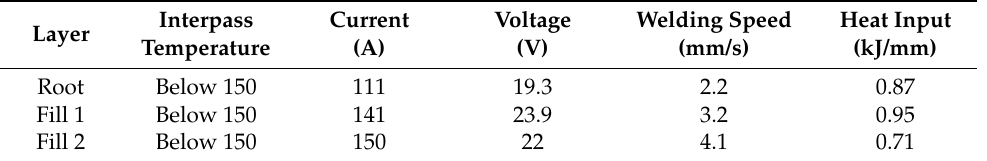
Table 6. Welding parameters for joints without misalignment.